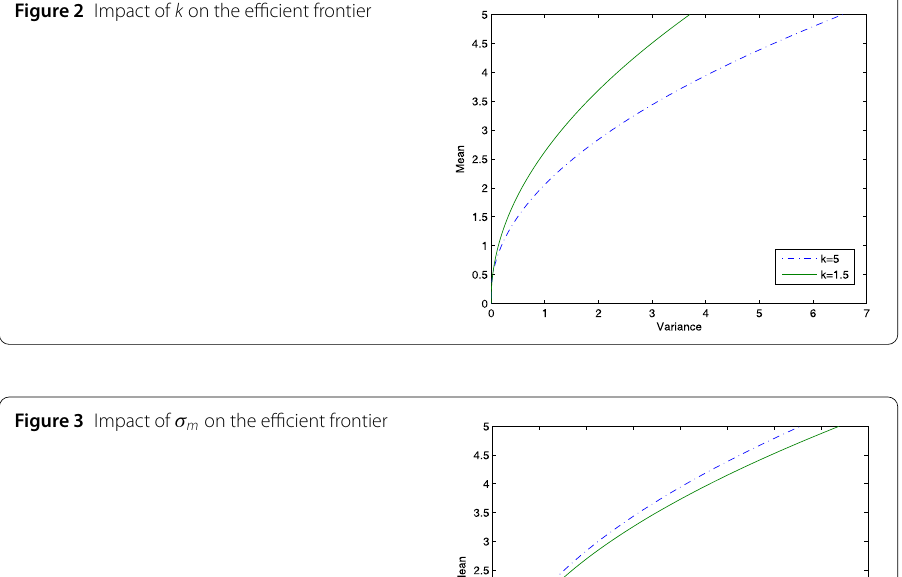
Figure 3 Impact of σ m on the efficient frontier